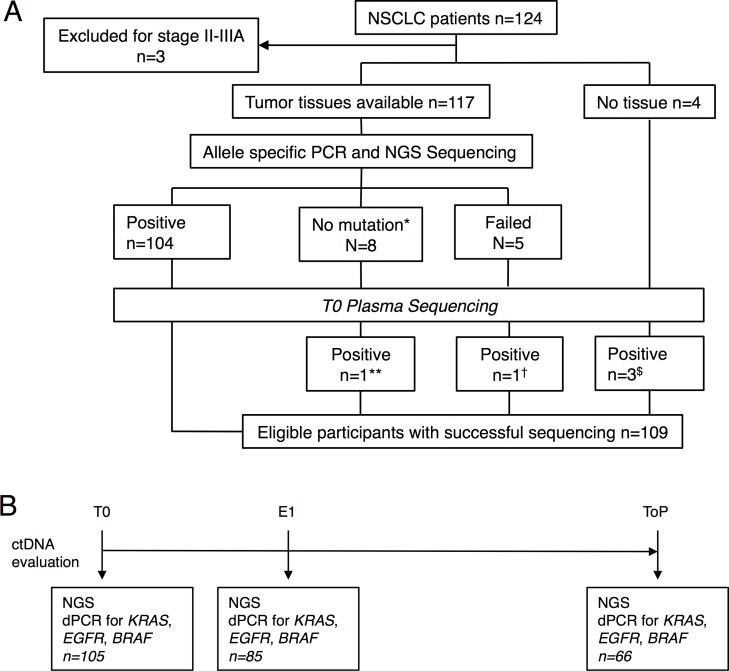
Study design.(A) Flowchart of the study population. (B) Time point of ctDNA follow-up. *Includes ALK fusion (n = 3) and ROS1 fusion (n = 1). **PIK3CA p.H1047L. †TP53 p.Gly244Cys. $KRAS p.G12V, TP53 p.C135Y, and TP53 p.R248W. No mutations were found for AKT1, ERBB2, FBXW7, FGFR2, MET, or NOTCH1.